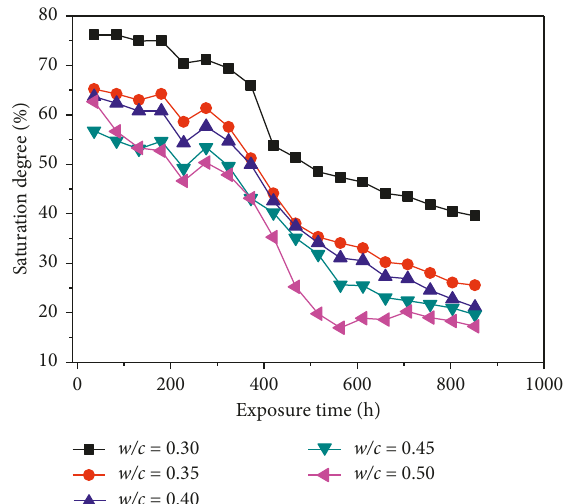
Figure 7: The change law of saturation degree ( S ) with exposure time.